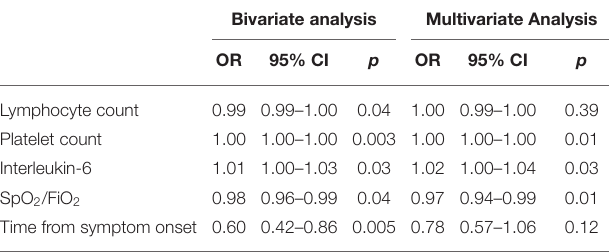
TABLE 4 | Logistic regression of baseline variables associated with treatment